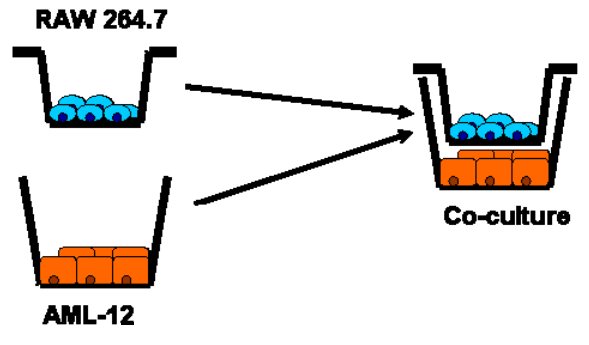
Figure 4. Schematic drawing of co-culture model (as used by Spruss et al.